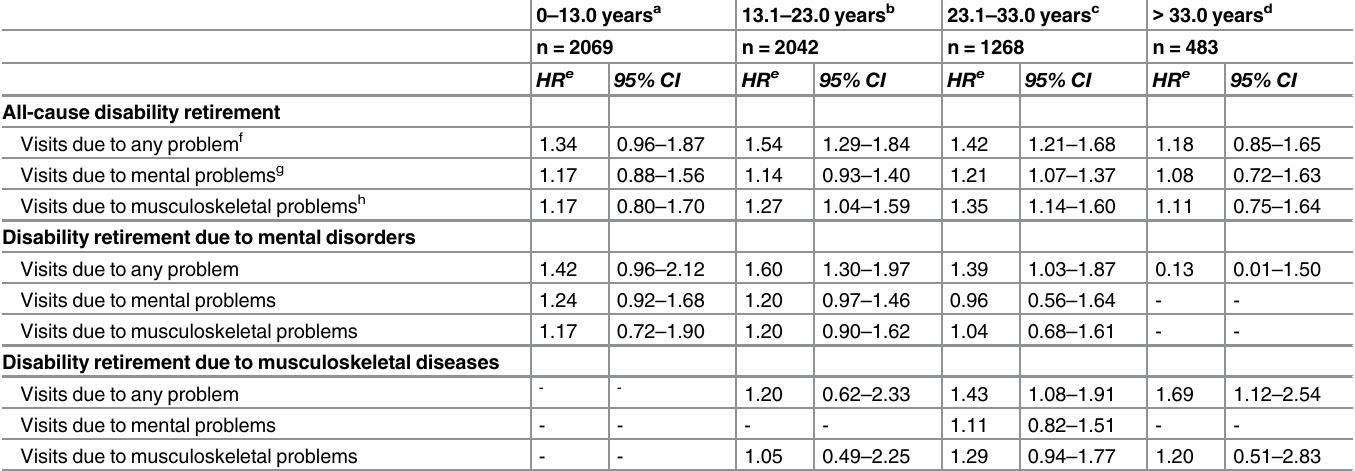
Table 5. Seeking care (visits per service months) during military service and disability retirement by the length of follow-up time